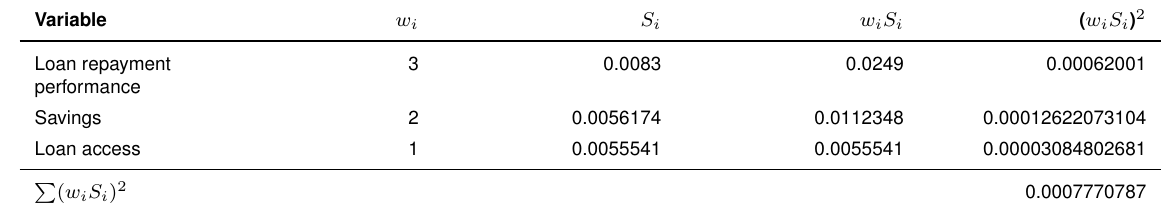
Table 6. Calculation of accuracy using uncertainty analysis.